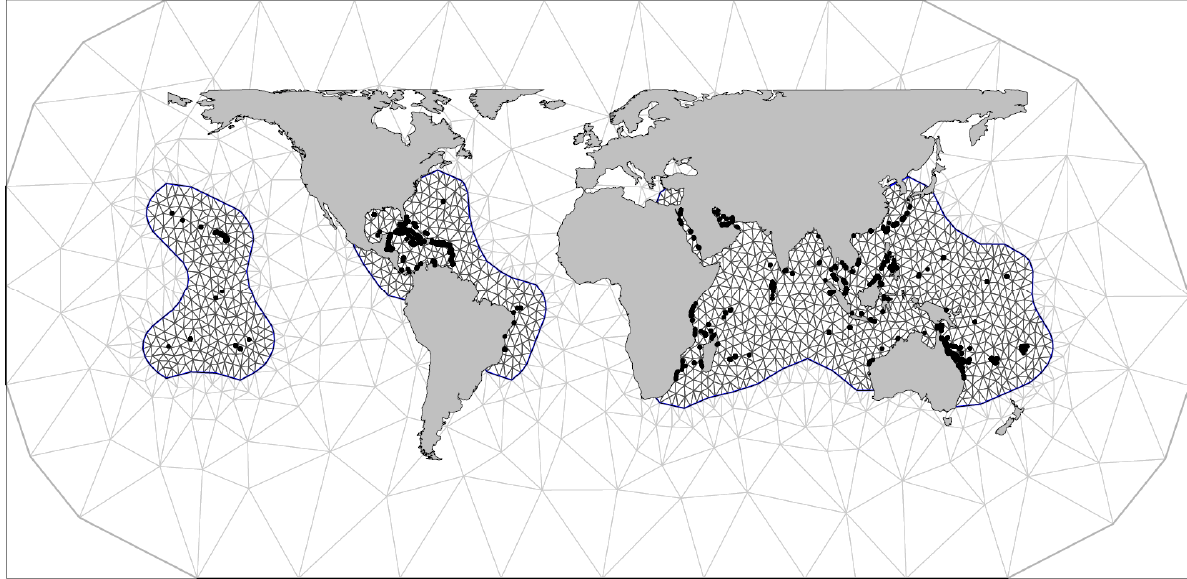
Figure 2. Constrained refined Delaunay triangulation mesh of 1790 nodes used for spatial correlation in one timestep. The spatiotemporal correlation over 15 years is computed over 15 such meshes totalling 26,400 nodes. Continents and bleaching survey coordinates (black points) overlay the higher resolution study area (black mesh) and lower resolution convex hull (grey mesh).